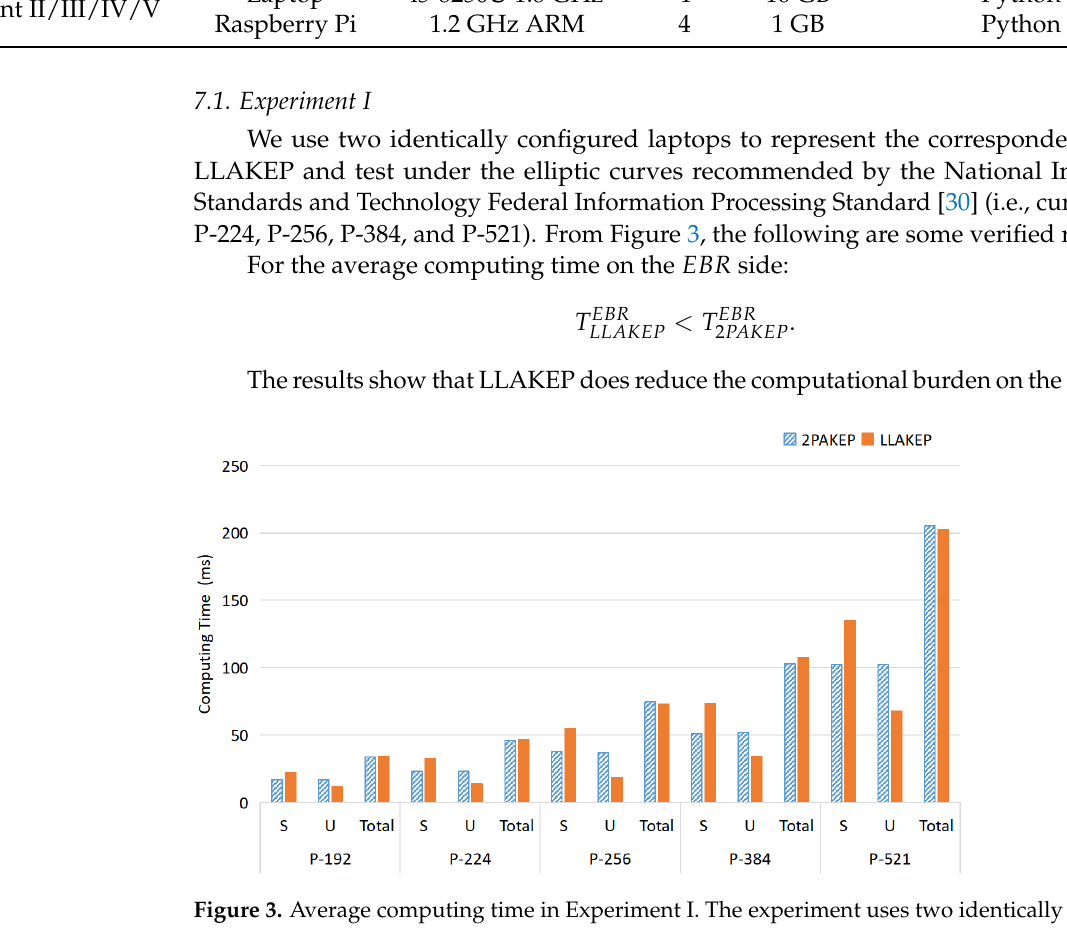
Figure 3. Average computing time in Experiment I. The experiment uses two identically configured laptops to represent two parties of the LLAKEP. The results are as follows: (1) the calculation time on the U side using LLAKEP is less than 2PAKEP; (2) LLAKEP does reduce the computational burden on the EBR’s